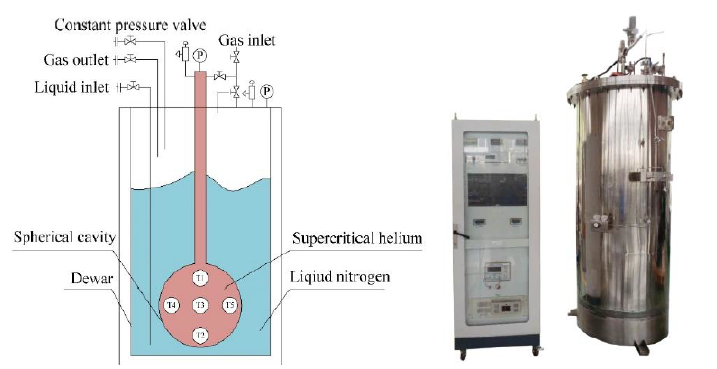
Figure 3. Schematic diagram and the picture of the supercritical helium natural convection test